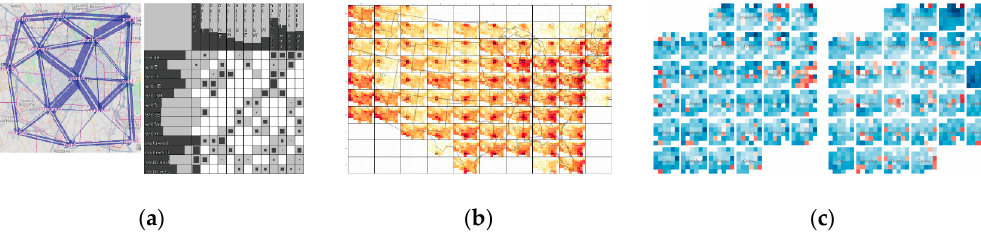
Figure 54. OD matrix visualizations: ( a ) traffic flow map (left) and corresponding OD matrix (right) in Milan [139]; ( b ) embedding-based population migration map of the United States [134]; and ( c ) percentage difference in spatial migration [141].